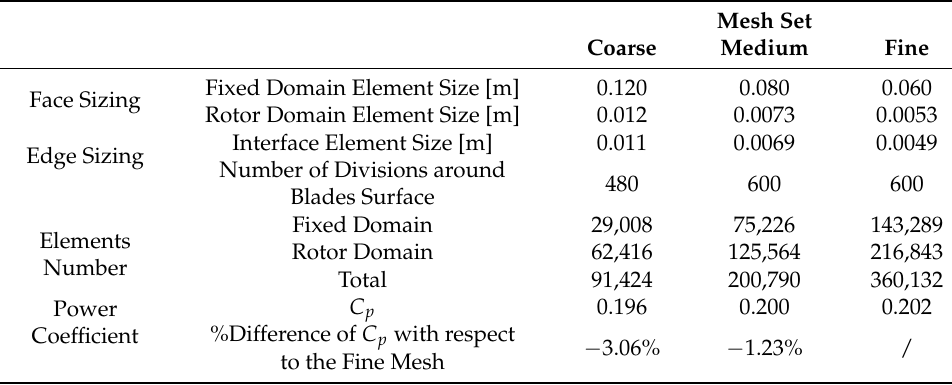
Table 4. Mesh Independence Test for λ =